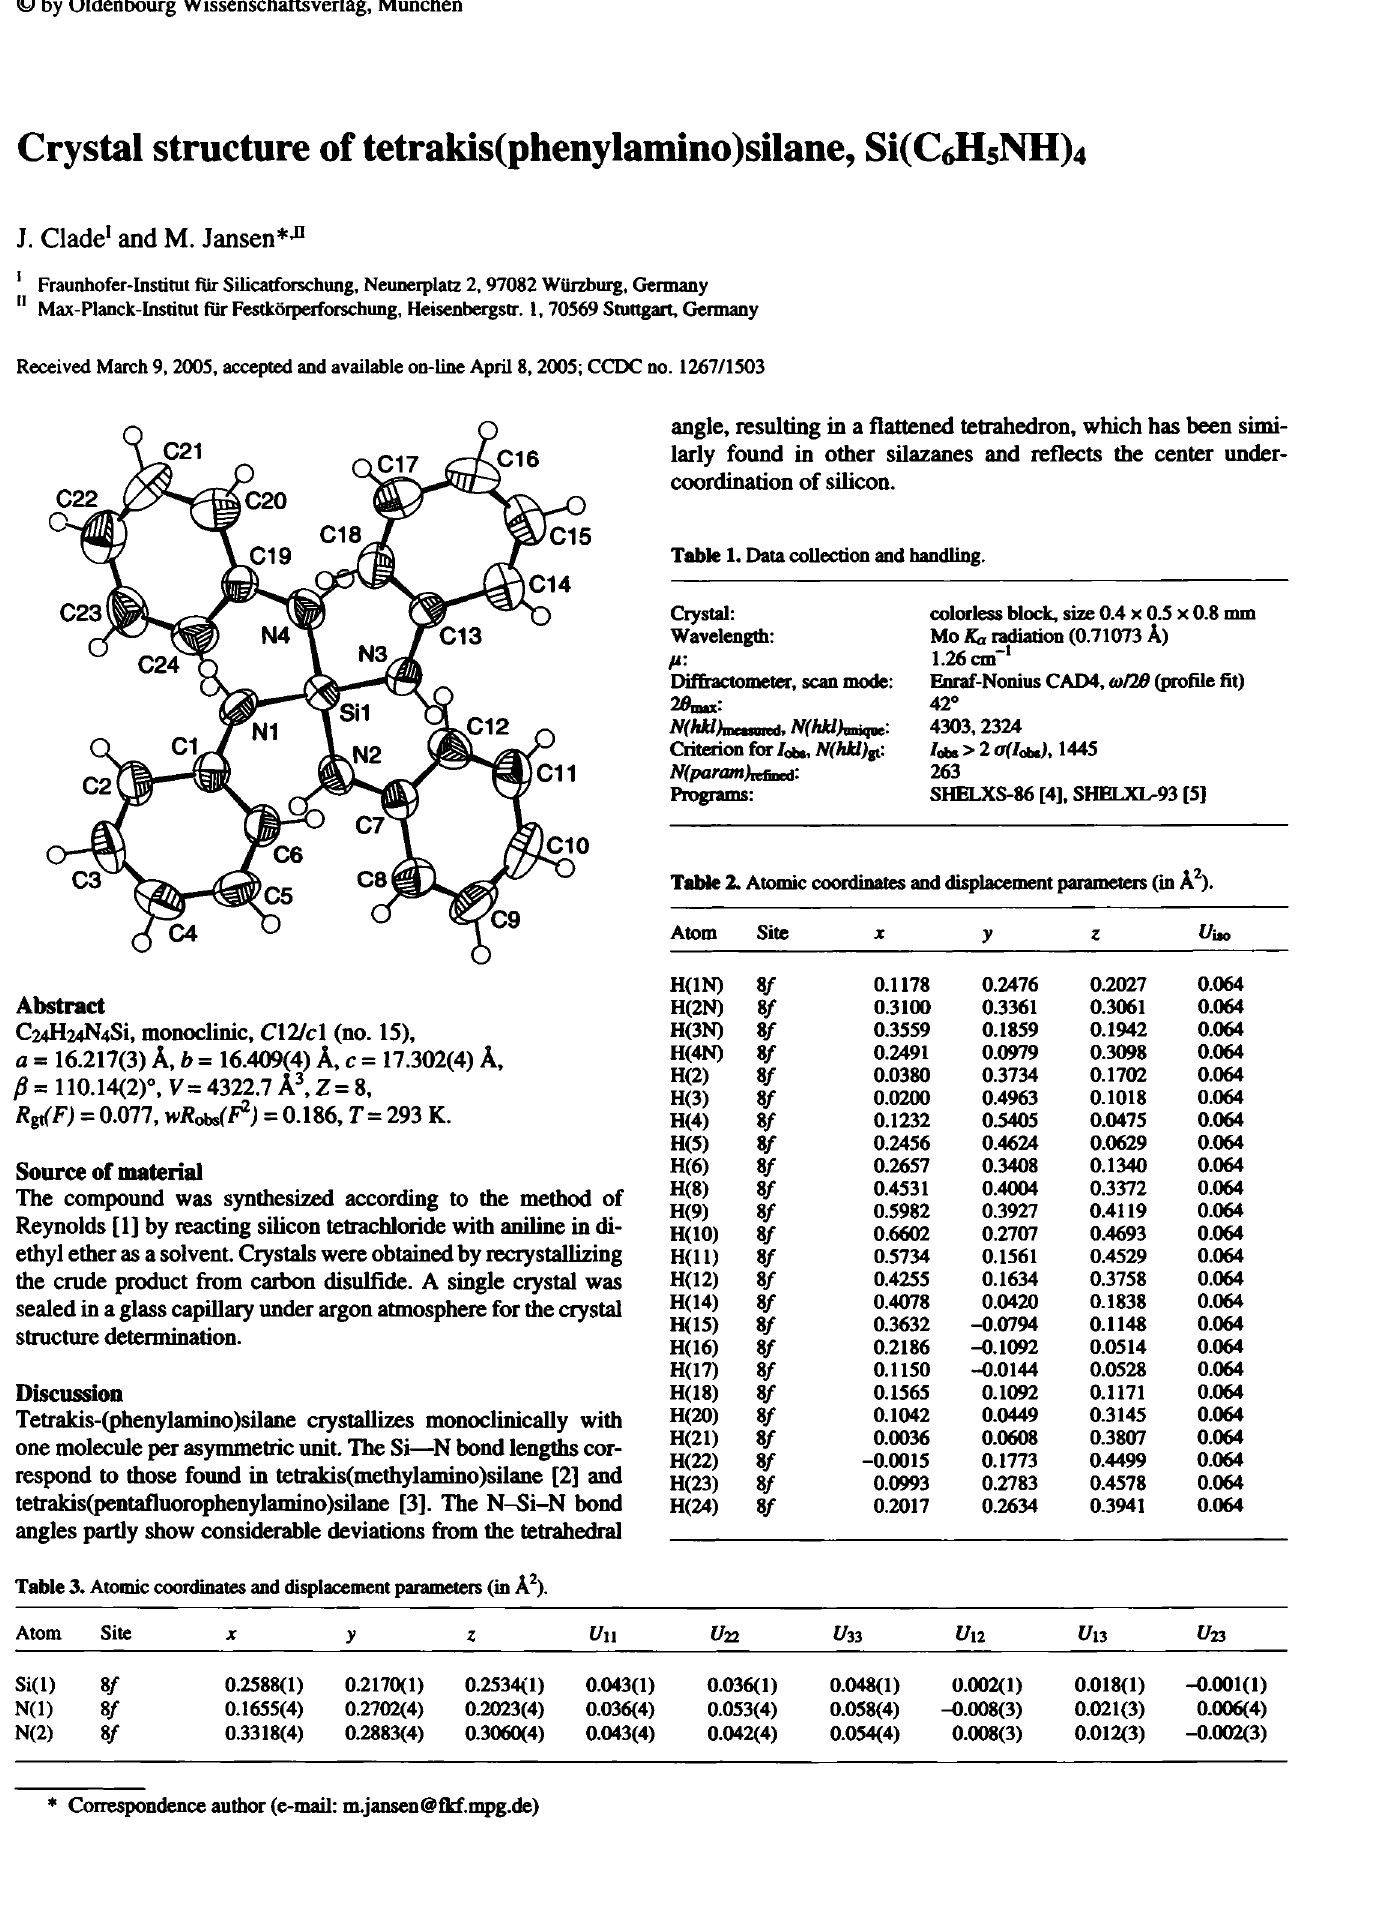
Table 3. Atomic coordinates and displacement parameters (in A 2 ).